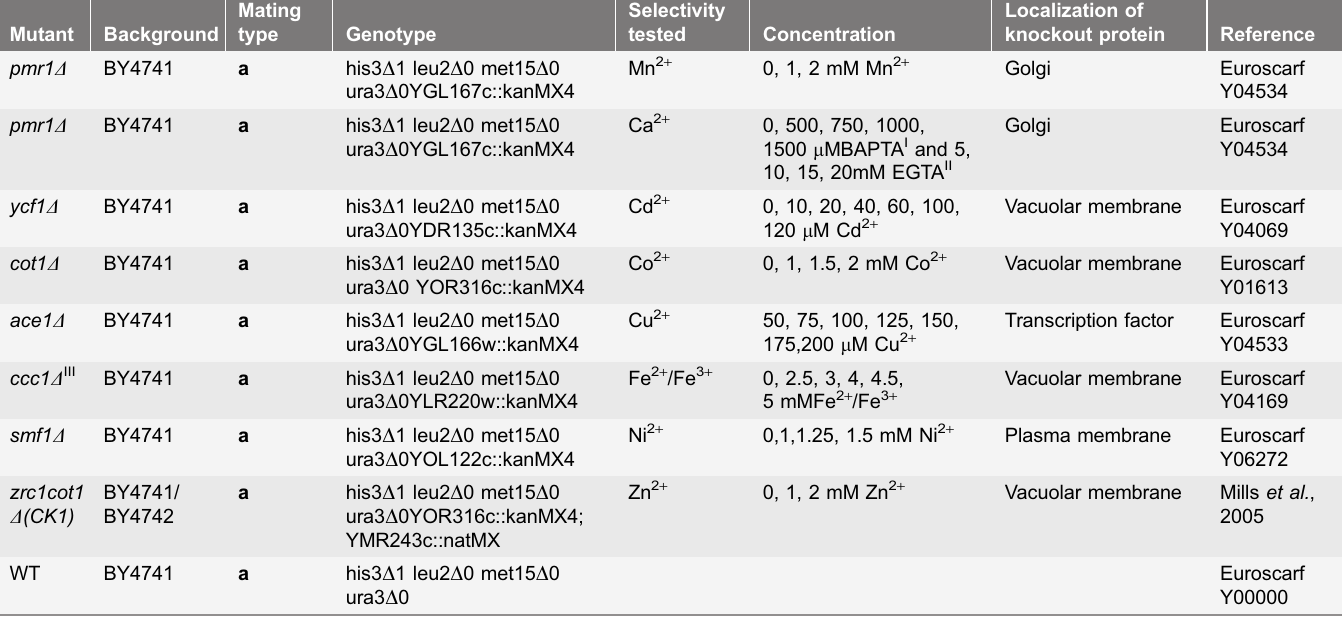
Table 1. List of yeast ( Saccharomyces cerevisiae ) strains used in this study. Mating Mutant Background